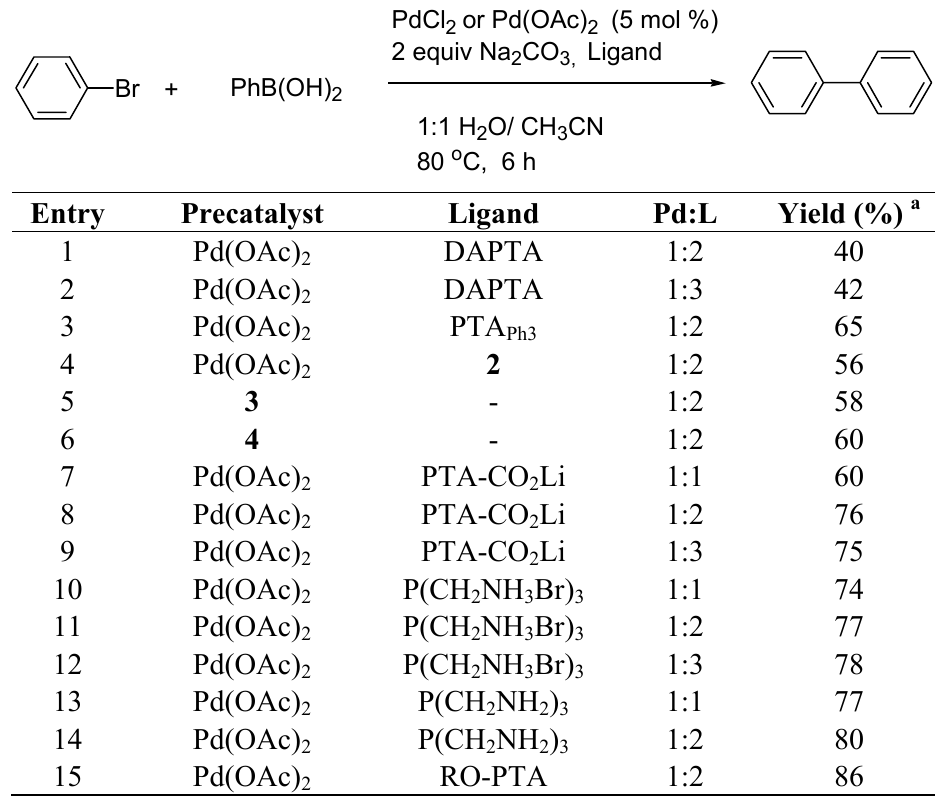
Table 2. Palladium catalyzed Suzuki coupling reactions in aqueous media utilizing water- soluble PTA